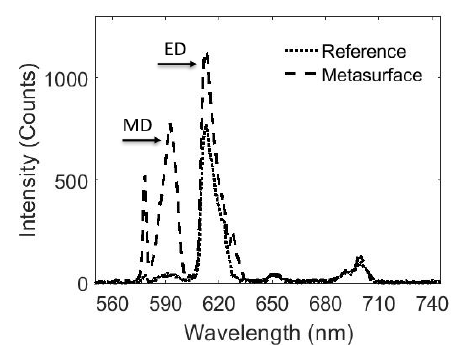
Fig. 2. The PL emission spectra of the Eu (cid:3)(cid:4) doped PMMA covered